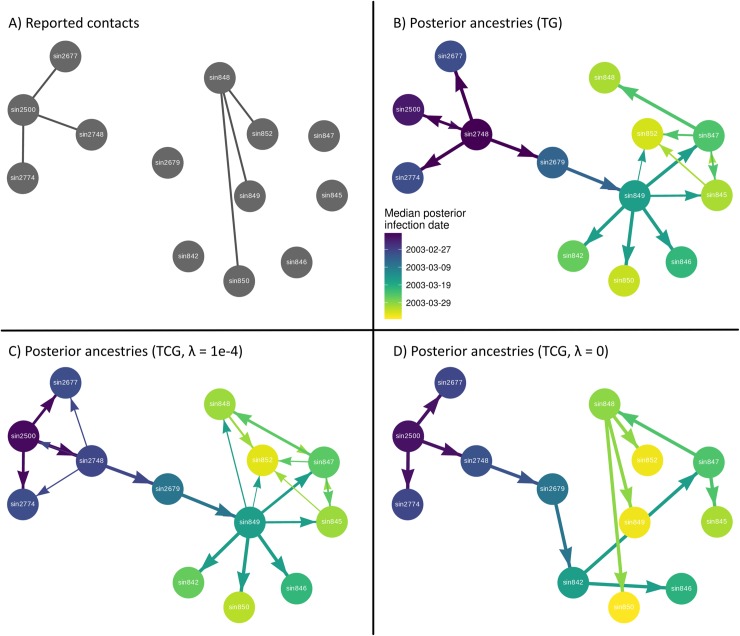
Reconstruction of the 2003 SARS outbreak in Singapore.A) Circles represent individual cases, and edges the epidemiological contacts reported between them. B) The outbreak was reconstructed using temporal and genetic data. Arrows represent posterior ancestries between cases, scaled in width by the posterior frequency of that ancestry. Ancestries with a minimum posterior frequency of 0.01 were included. The color of a node corresponds to the median posterior infection time of that case. C) The outbreak was reconstructed using temporal, contact and genetic data, and the non-infectious contact probability λ fixed at a value of 1e-4. D) The outbreak was reconstructed using temporal, contact and genetic data, and the non-infectious contact probability λ fixed at a value of 0.